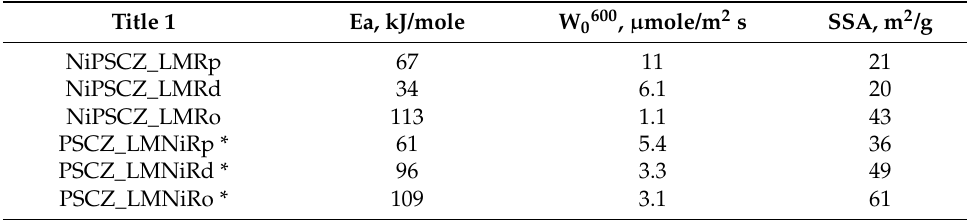
Table 2. Kinetic regularities calculated for NiPSCZ_LMR and PSCZ_LMNiR* catalysts.